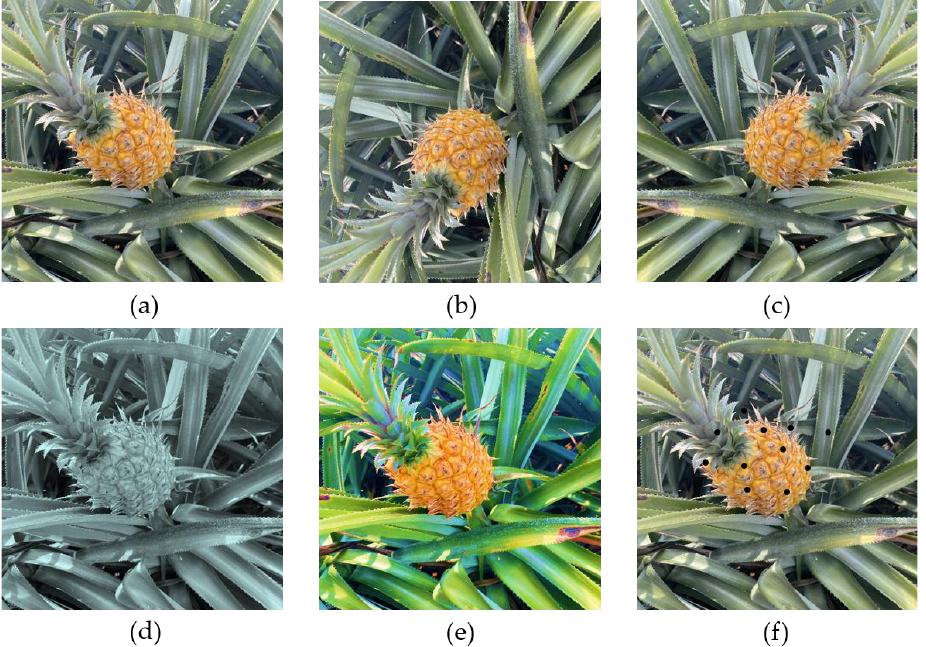
Figure 3. Image augmentation: ( a ) original image; ( b ) rotating; ( c ) flipping; ( d ) color; ( e ) brightness; ( f ) noise. Through the above means, the total number of data sets were expanded to 4340 im- ages. LabelImg was used as the image-annotation tool. The label file was saved in the XML format. When used, the label file format was adjusted according to the needs of the differ- ent networks. Among them, 3472 pictures were used as the training set, 434 pictures were used as the verification set, and 434 pictures were used as the test set. The ratio of the three was 8:1:1. The data set structures are shown in Table 2. Table 2. The details of the pineapple data set.